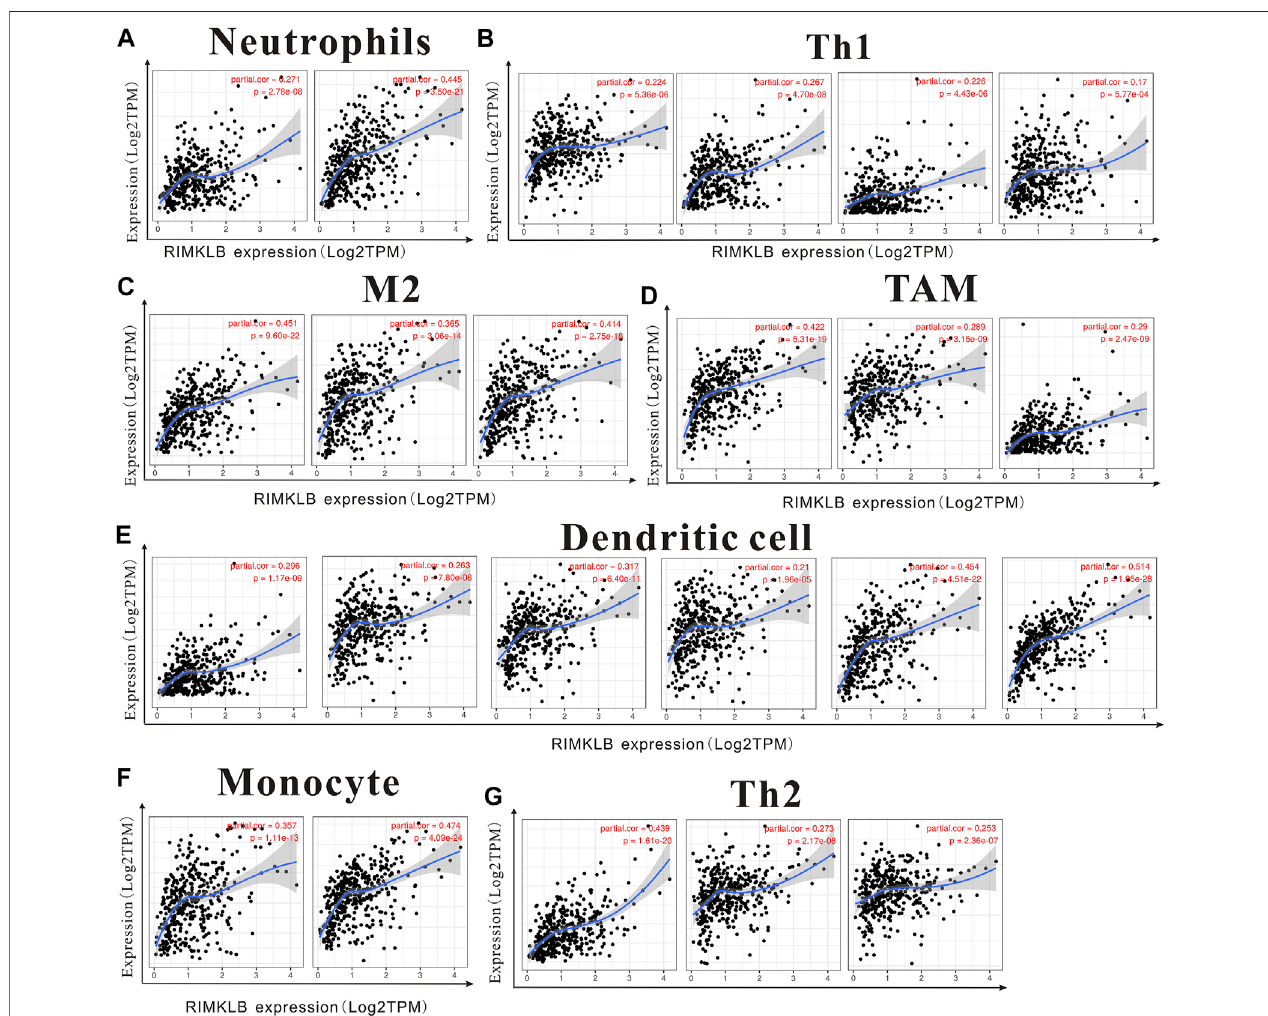
FIGURE 7 | The expression of RIMKLB and the correlation with immune in fi ltration in COAD (colon adenocarcinoma). Markers include ITGAM, and CCR7 of Neutrophils;TBX21,STAT1,STAT4,andTNFofTh1;CD86andCSF1Rofmonocytes;CD163,andVSIG4ofM2macrophages;CCL2,CD68,andIL10ofTAMs(tumor- associated macrophages); HLA-DPB1, HLA-DRA, HLA-DPA1, CD1C, NRP, and ITGAX of Dendritic cell; GATA3, GATA6, and GATA5A of Th2. (A – G) Scatterplots of correlationsbetweenRIMKLBexpressionandgenemarkersofNeutrophils (A) ,Th1 (B) ,andM2macrophages (C) ,TAMs (D) ,Dendriticcell (E) ,monocytes (F) ,and Th2 in COAD (G)